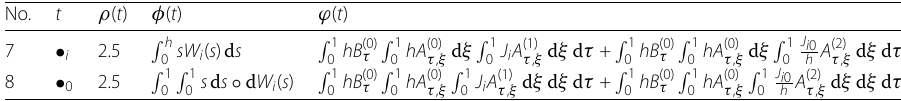
Table 3 Colored rooted tree for (5.8) with order equal to 2.5 No. t ρ ( t ) φ ( t